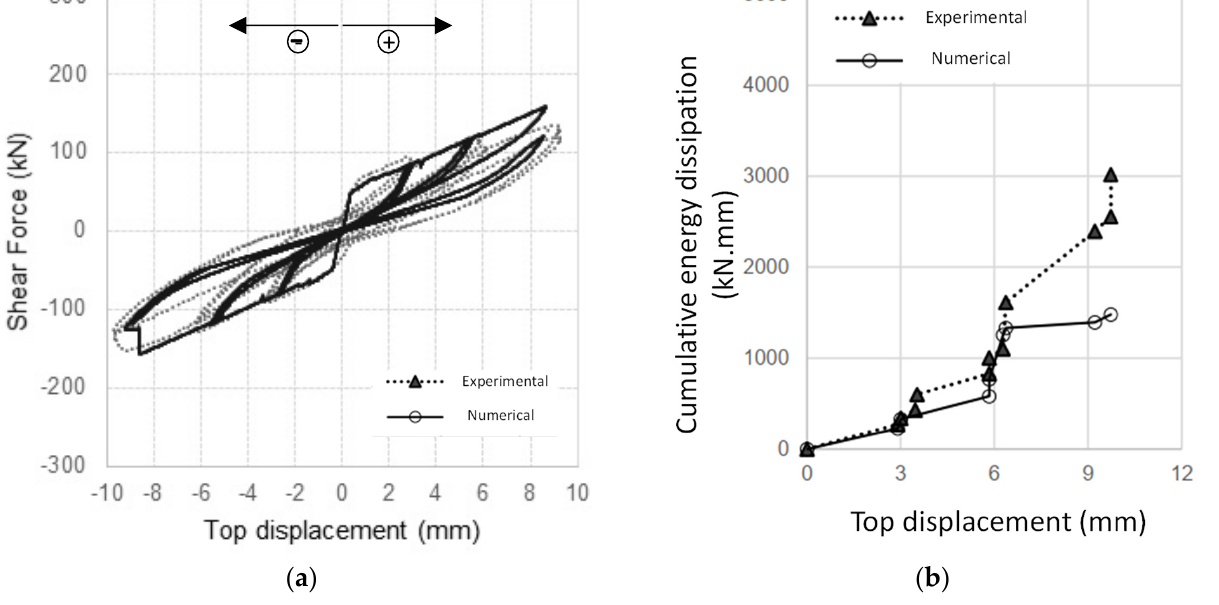
Figure 5. Numerical simulation of the specimen Inf_14 (wall w/ opening): ( a ) force–displacement curves; and ( b ) cumulative energy